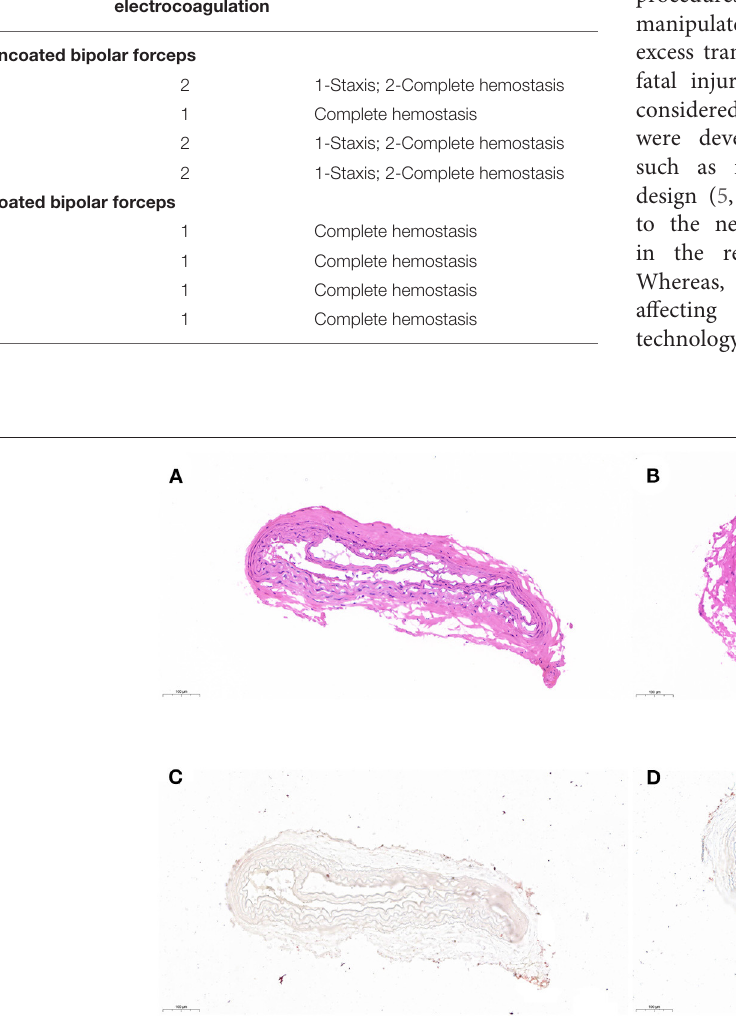
FIGURE 5 | Histological examination of coagulated CCA. H&E staining of coagulated CCA with uncoated (A) and BW coated (B) bipolar forceps. Oil red O staining of coagulated CCA with uncoated (C) and BW coated (D) bipolar forceps. The waxy barrier was pointed with the arrow.